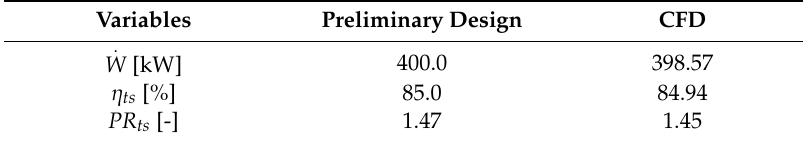
Table 4. Comparison of results between preliminary design and CFD at α 2 b = 70.4 ◦ .